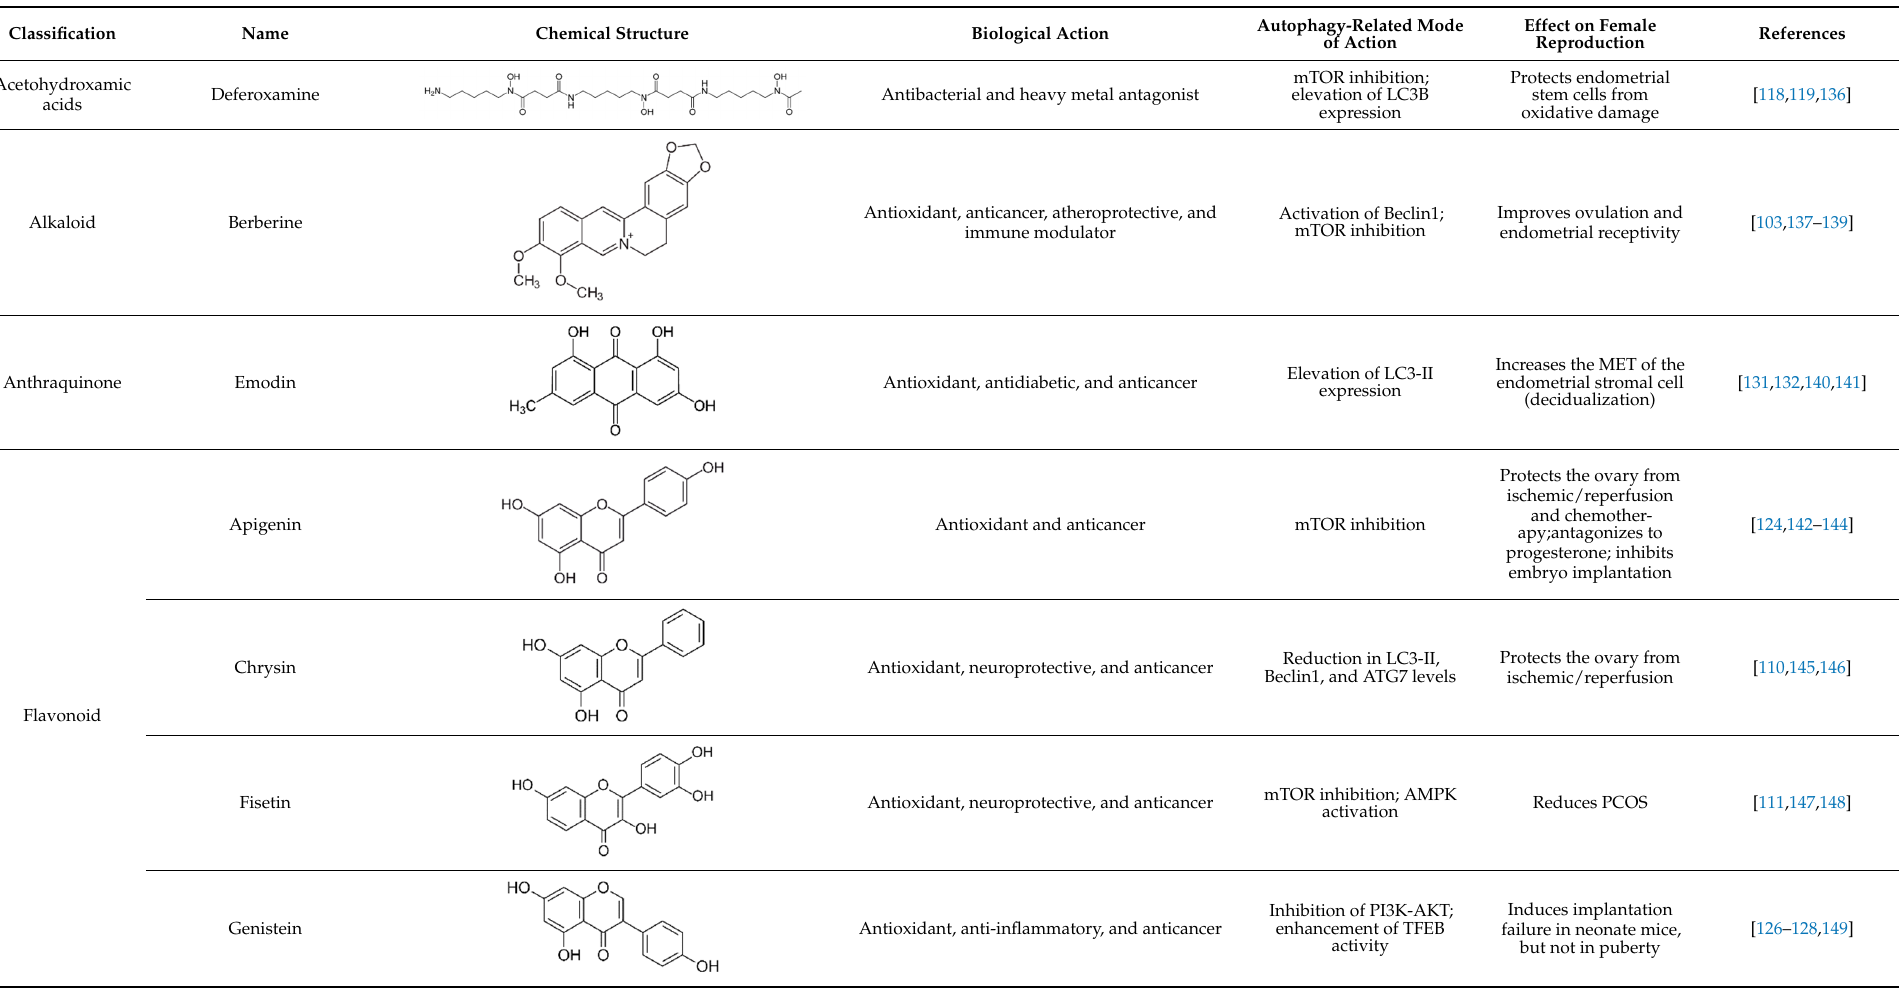
Table 1. Effects of natural product autophagy regulators on female fertility.